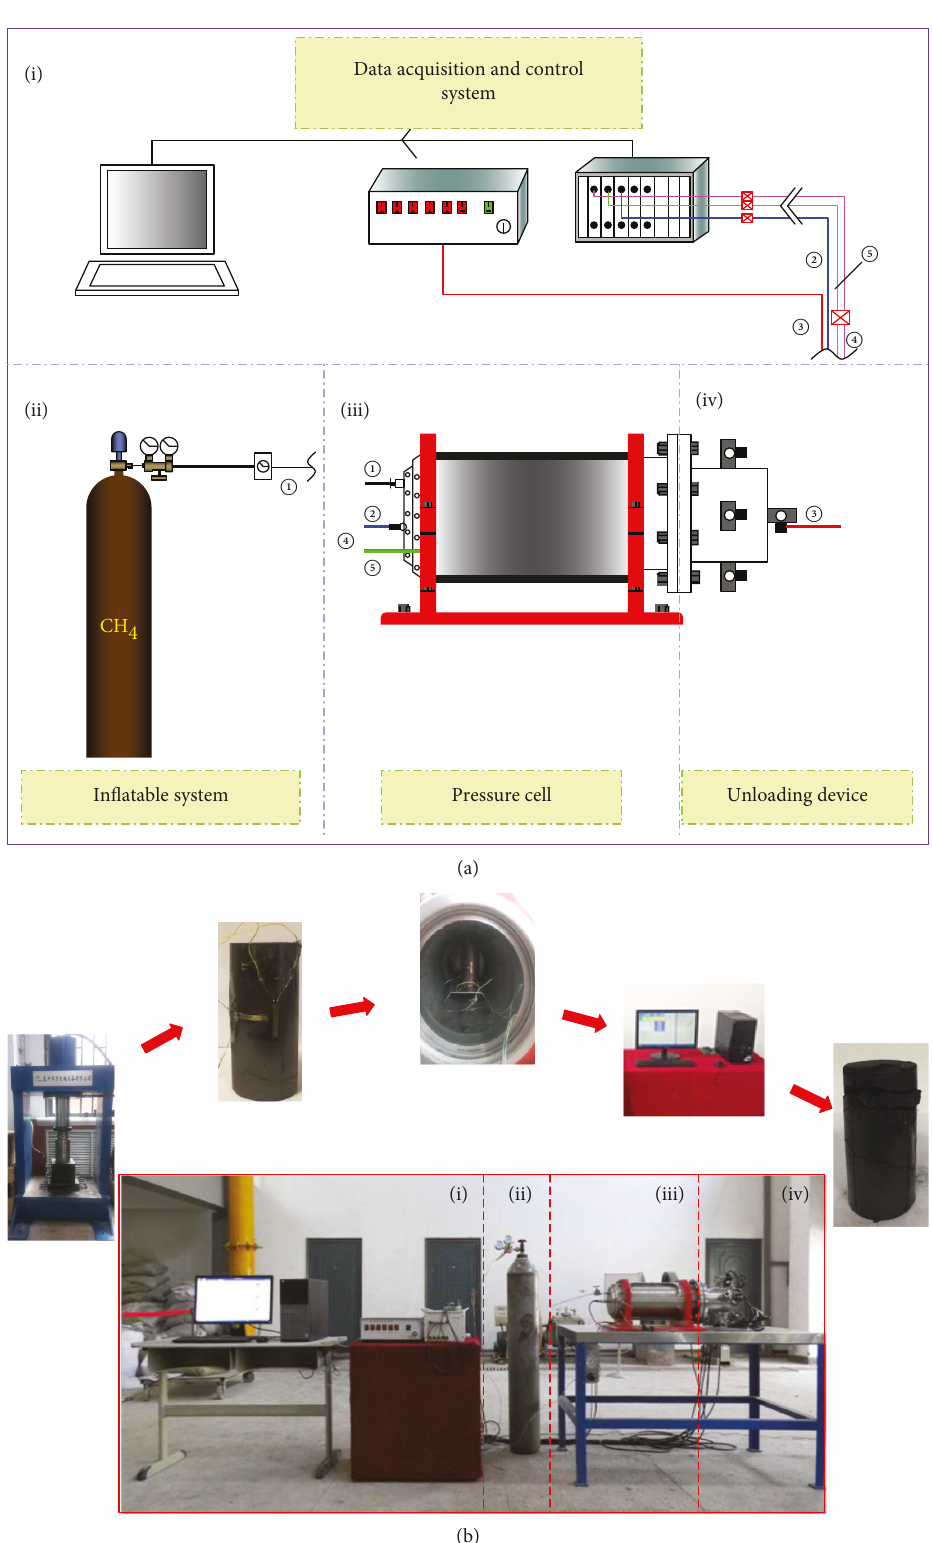
Figure 4: The schematic and operation steps of experimental system for sudden unloading of gas-bearing coal samples. (a) Schematic of the system principle: ① air-conducting tube, ② gas pressure detector, ③ solenoid valve, ④ strain gauge 1, and ⑤ strain gauge 2. (b) Apparatus system and its operation